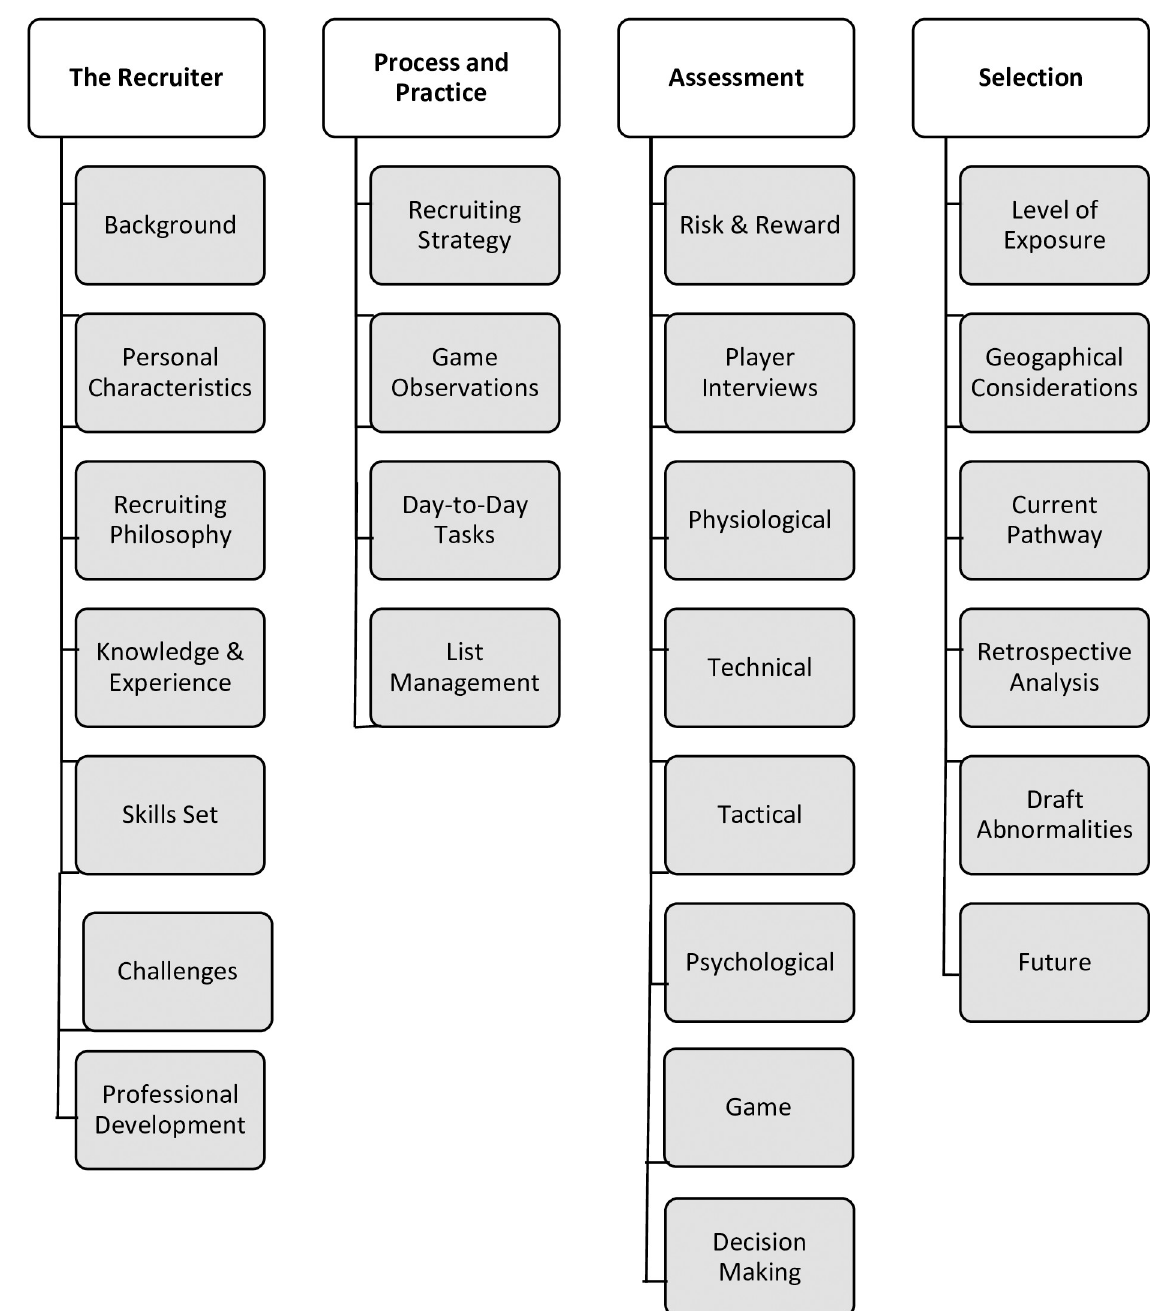
Fig 1. Schematic of first order themes (white boxes) and second order themes (grey boxes).